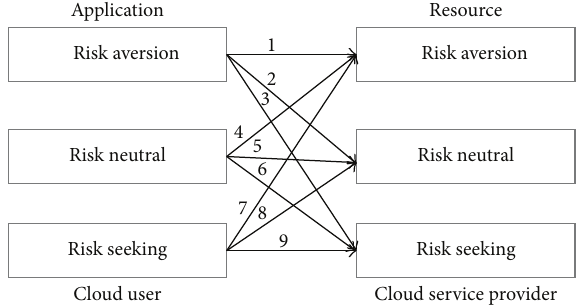
Figure 3: Mapping of cloud users risk to resource providers